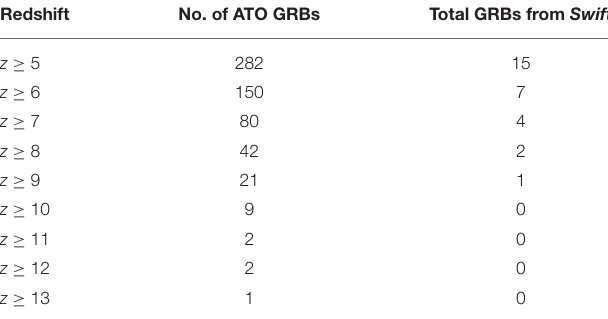
TABLE 1 | ATO GRBs over 5